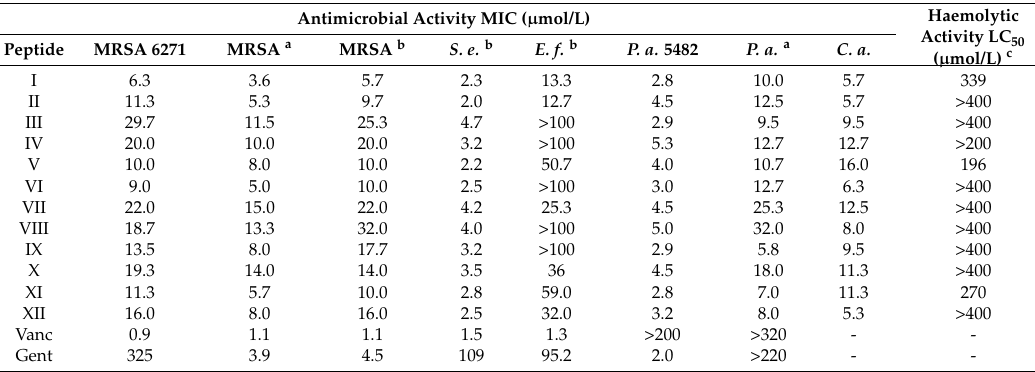
Table 2. Antimicrobial and haemolytic activity of peptides I–XII and antibiotics. Antimicrobial Activity MIC ( µ